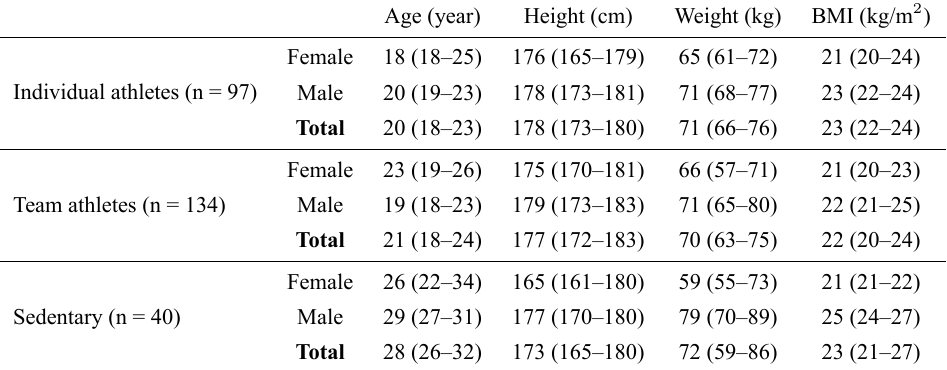
Table 1. Participants’ physical characteristics according to sports disciplines (Median-IQR) (n = 271).